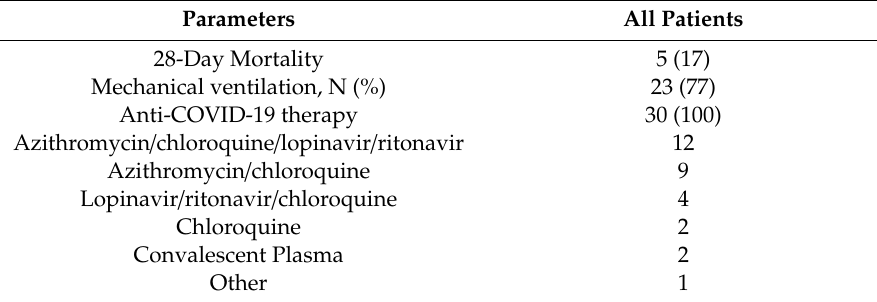
Lopinavir / ritonavir / chloroquine Chloroquine Convalescent Plasma Other 1